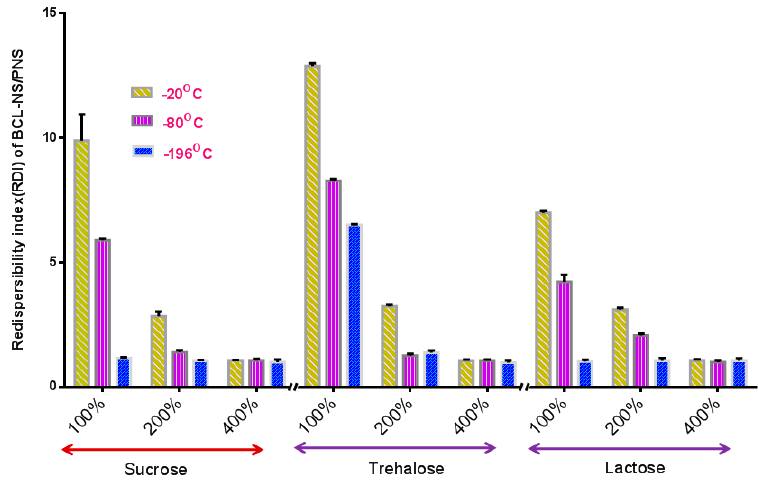
Figure 4. Redispersibility of BCL-NS/10% PNS combined with different concentrations of cryoprotectants during freezing (mean ± S.D., n = 3).